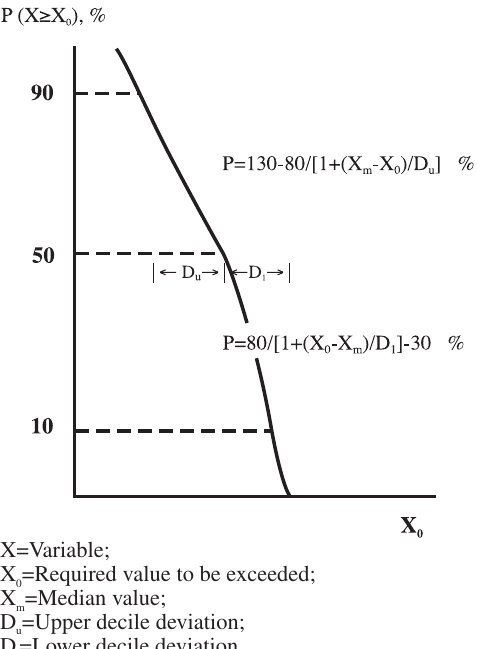
(1976).X=Variable; X =Required value to be exceeded; 0 X =Median value; m D =Upper decile deviation; u D =Lower decile l Fig. 3. Idealised cumulative-amplitude probability distribution fitted to median and decile deviation values, from Bradleyy and Bredford